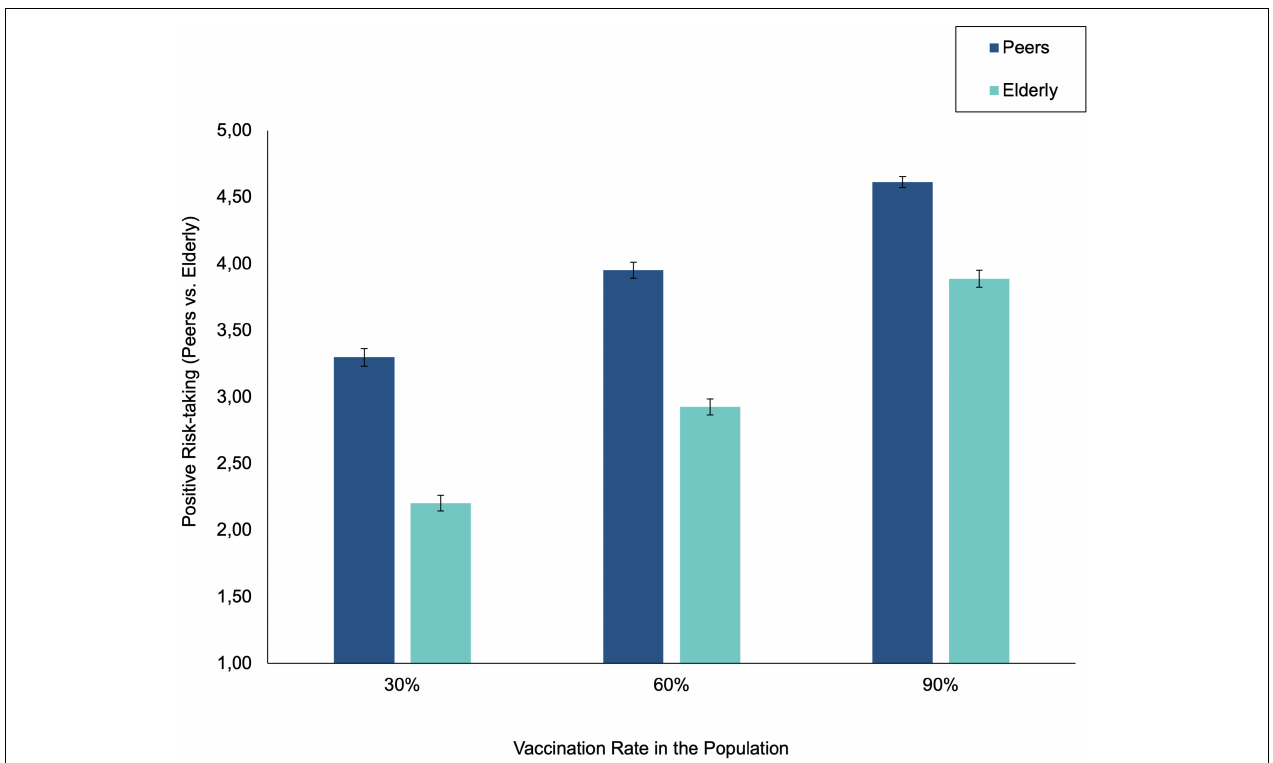
FIGURE 2 | Average positive risk-taking to peers versus elderly (i.e., non-adherence to social distancing and contract restriction). Larger differences between elderly and peers, combined with lower distinctions between high versus low vaccination rates, are indicative of positive risk-taking during COVID-19.